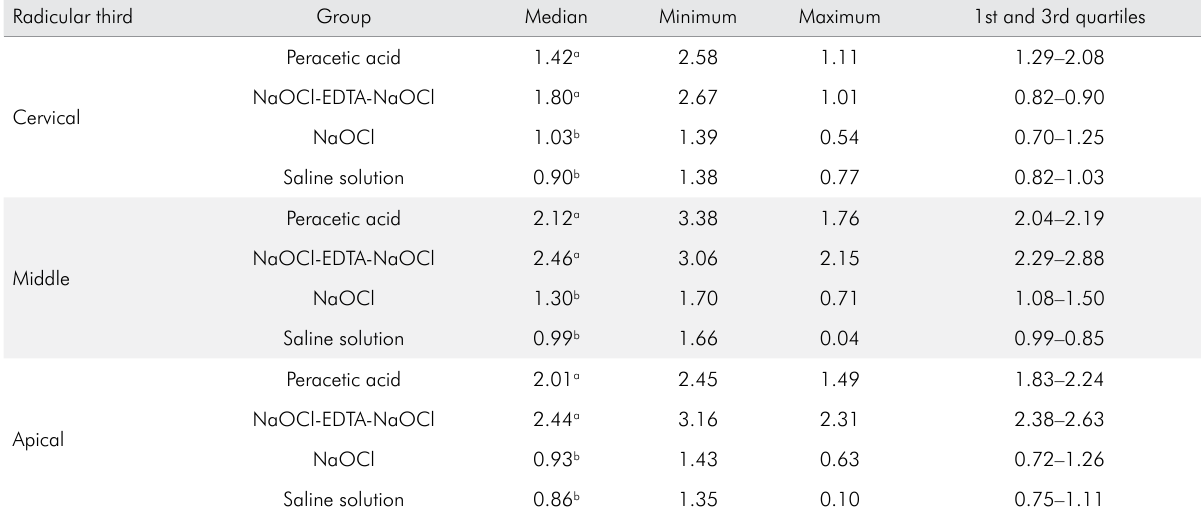
Table 2. Intraradicular dentin bond strength (in MPa) after root canal preparation using different irrigant solutions. Radicular